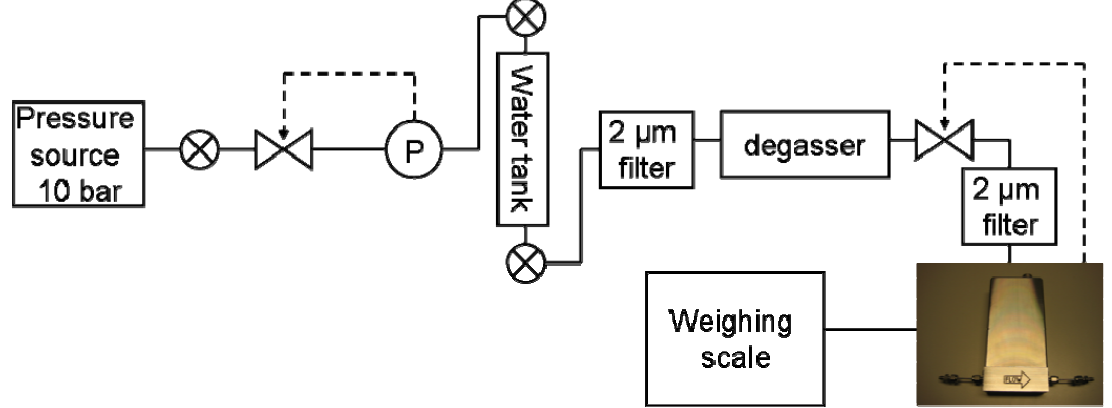
Figure 5. Schematic overview of the setup used for the water mass flow measurements. A water tank is pressurized by helium. The helium pressure is controlled using pressure meter P . The water is filtered directly after the tank and again between the valve and the Coriolis mass flow meter. A degasser removes air from the water. As a reference, an AX205 weighing scale was